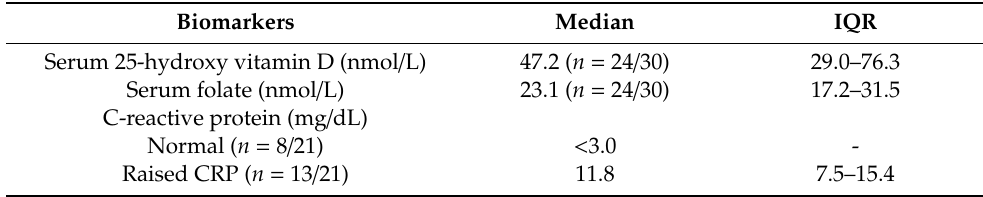
Table 5. Biomarkers in the polypectomy